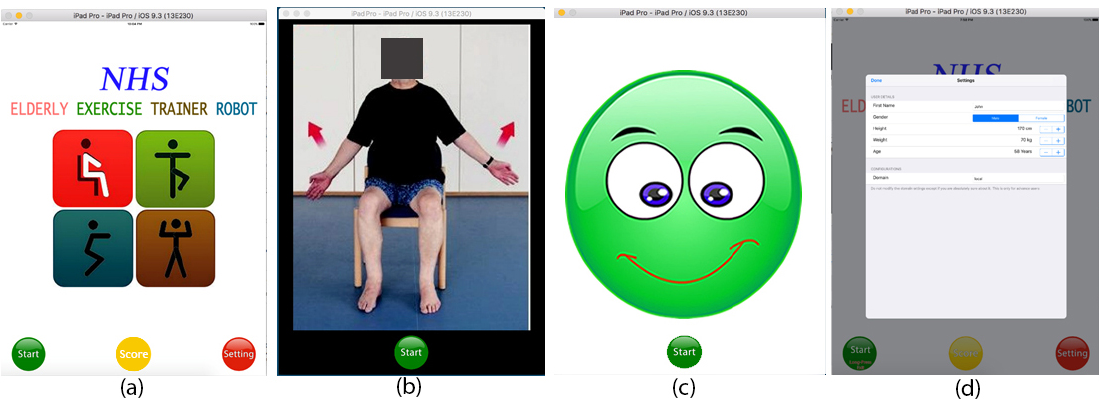
Figure 9. Display module application: ( a ) main menu; ( b ) exercise page; ( c ) feedback page; and ( d )